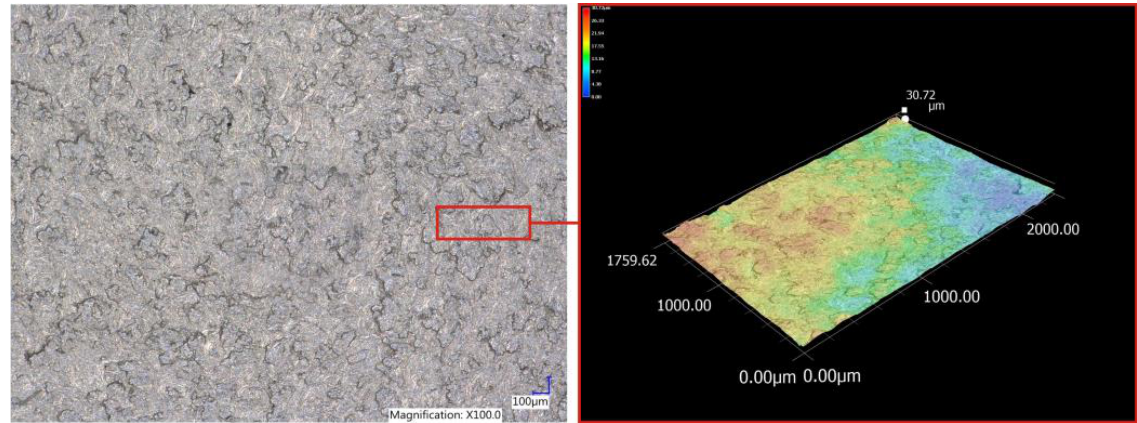
Figure 24. Display of surface texture and SH in constant Z strategy.